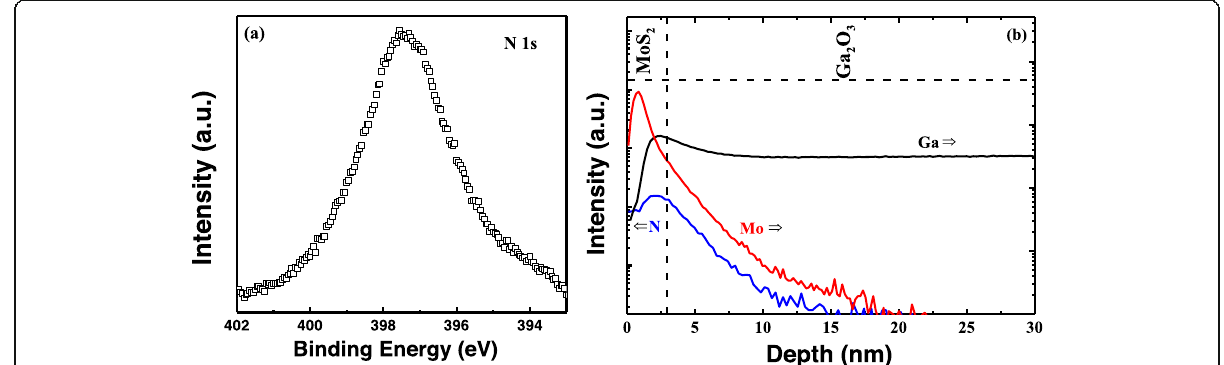
Fig. 3 a N 1 s XPS spectrum of β -Ga 2 O 3 substrate with surface nitridation. b SIMS depth profile of fabricated MoS 2 / β -Ga 2 O 3